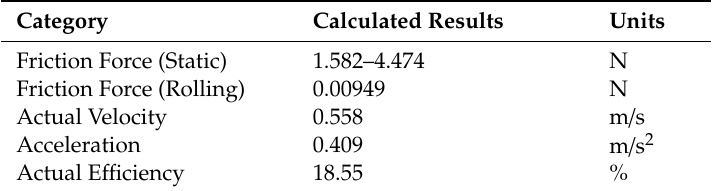
Table 2. Calculated Results